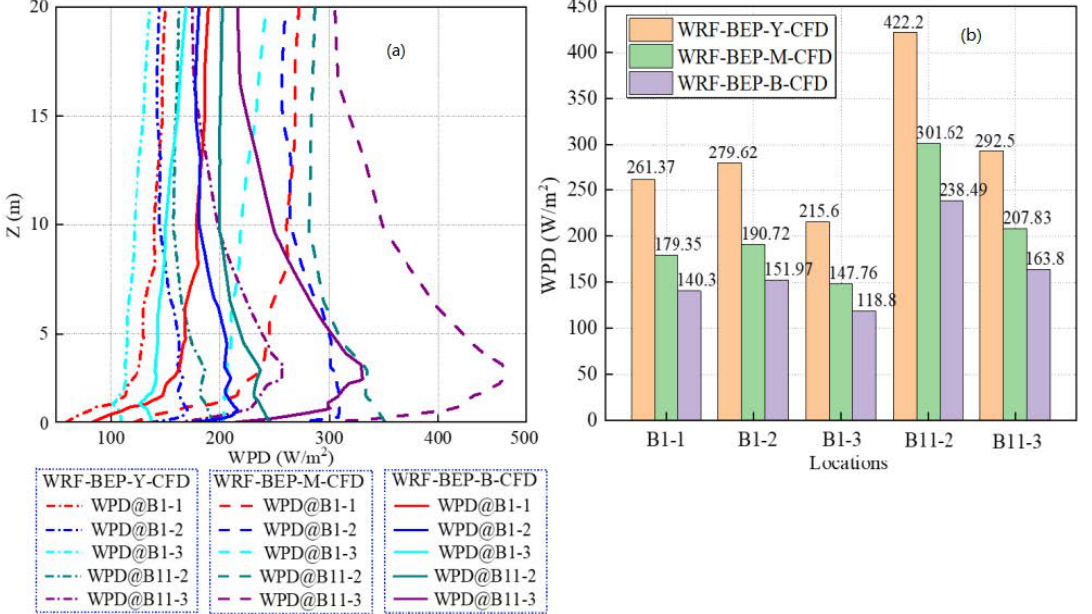
Figure 13. WPDs of five optimal installation locations based on three PBL parameterization schemes: ( a ) profiles along Z ; ( b ) values at the lowest installation heights.